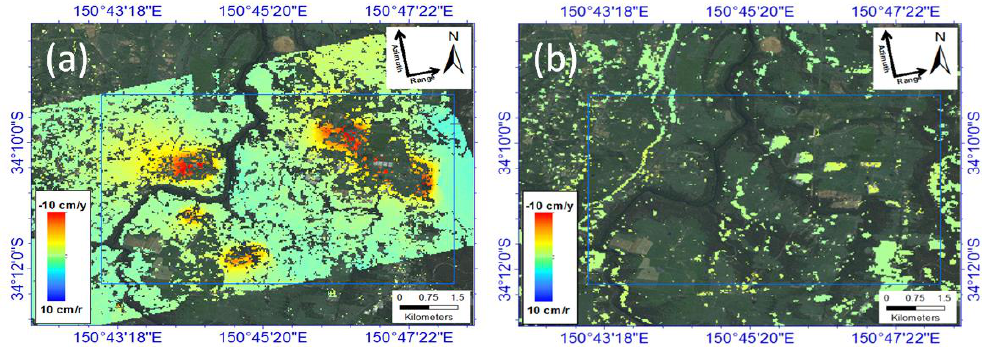
Figure 7. Comparison over Appin mining site between ( a ) L-band and ( b ) C-band, the resolution of each pixel is 30 m × 30 m.